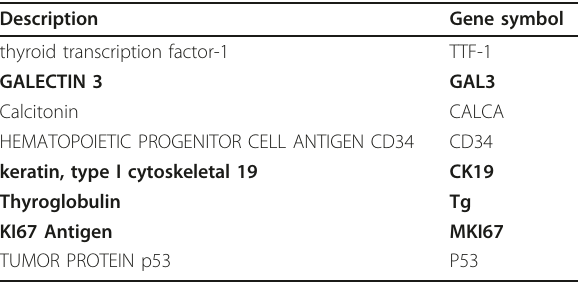
Table 1 Molecular markers used in the distinction of malignant from benign thyroid